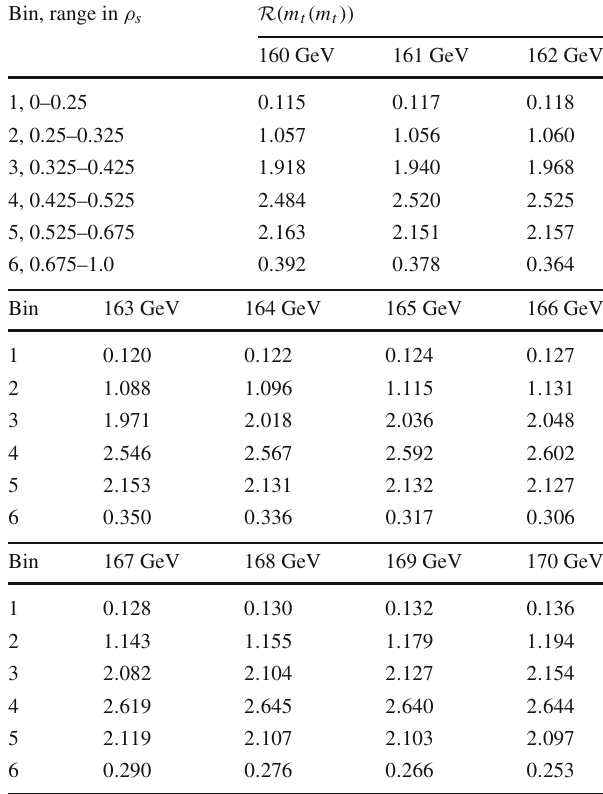
Table 3 Same as Table 1 but for the NNPDF2.3 PDF set. Only the central scale μ = m t ( m t ) is